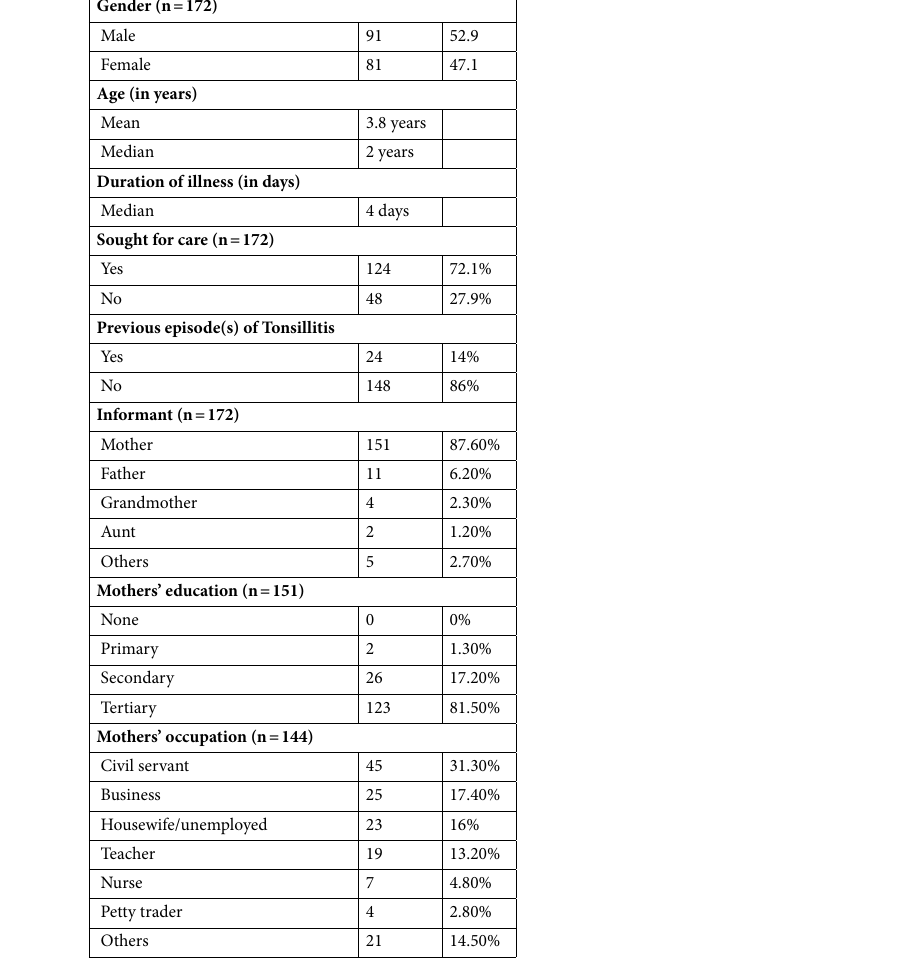
Table 1. Sociodemographic characteristics of the